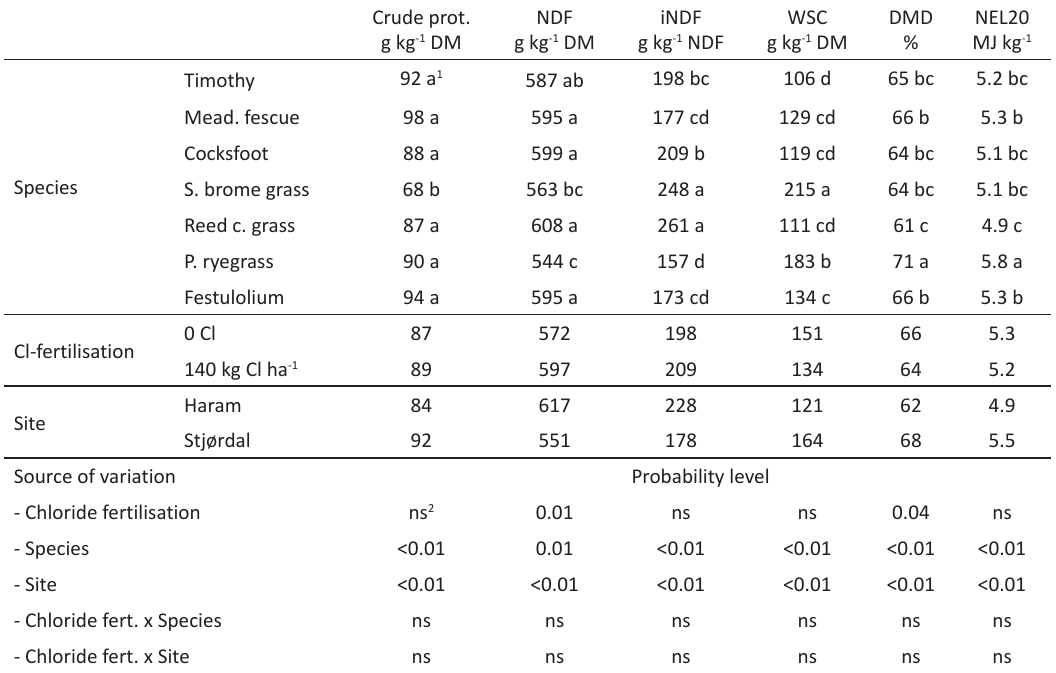
Table 6. Experiment 4: Forage concentrations of crude protein, fibre (NDF and iNDF) water soluble carbohydrates (WSC) and energy (NEL ), along with digestibility of dry matter (DMD) in the first cut of seven grass species grown at two sites 20 in one